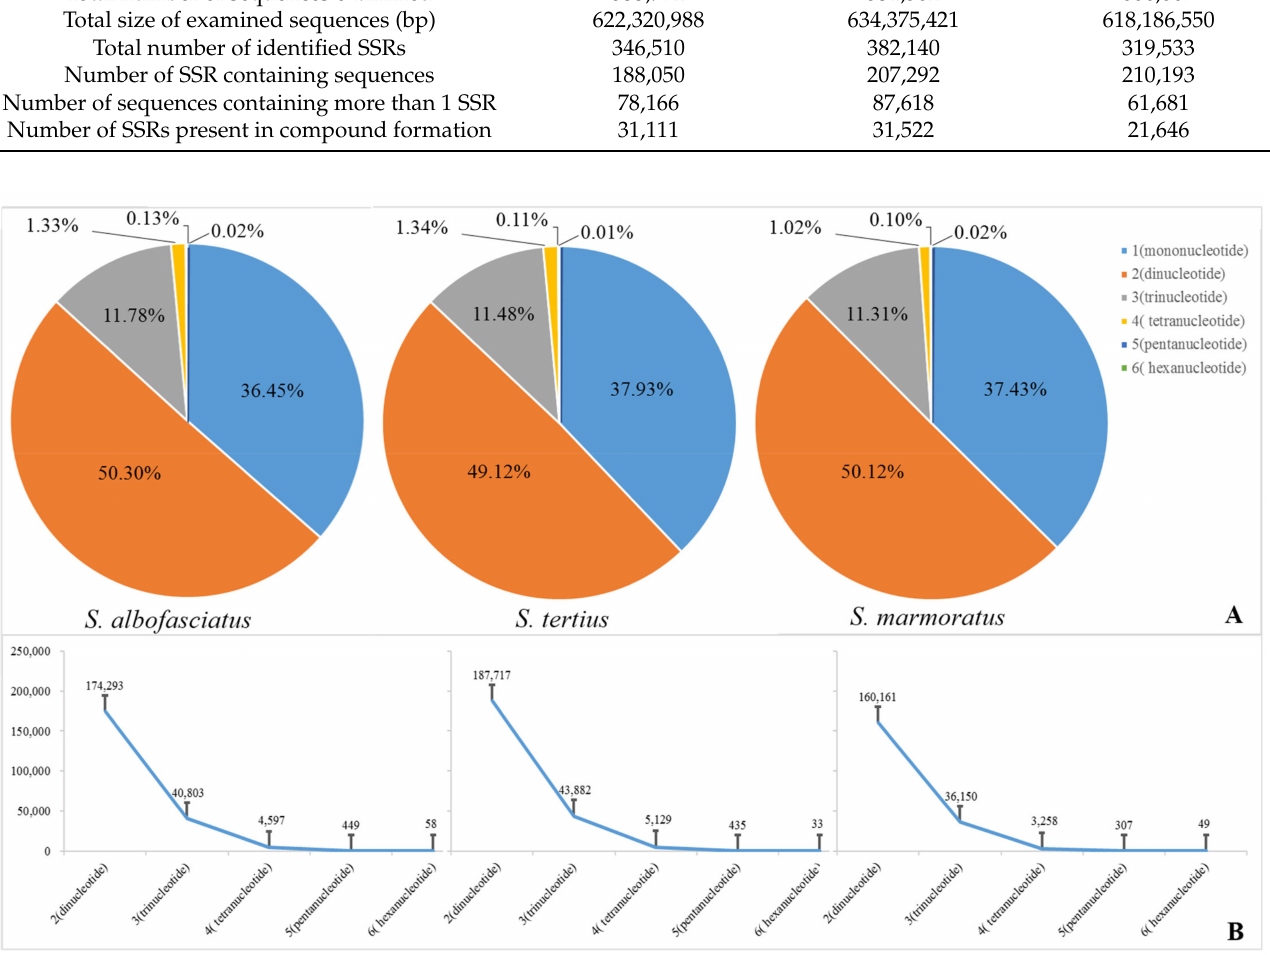
Figure 3. ( A ) Frequency of identified microsatellite motif types. ( B ) Quantity of identified microsatellite